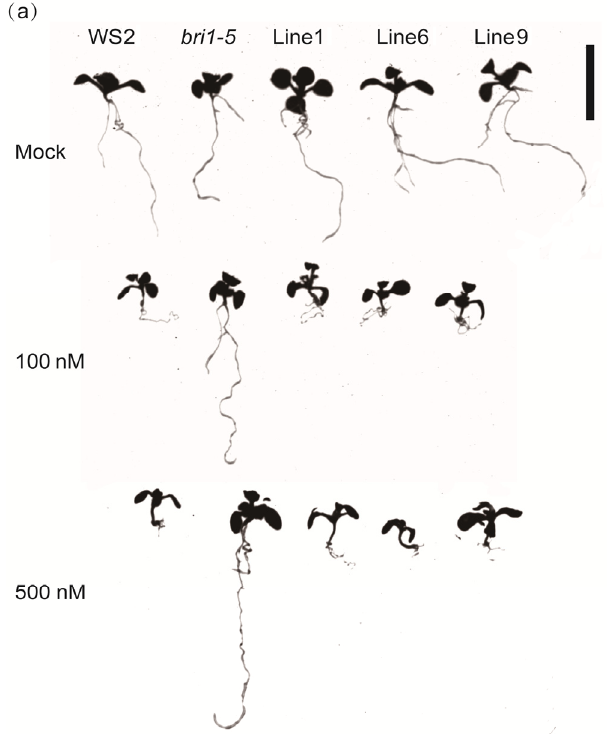
wide-type, bri1-5 mutant and transgenic lines. ( a ) Phenotypes of the wide-type (WS2), bri1-5 mutant and three transgenic lines (Line 1, 6 and 9) were grown in half-strength MS medium supplemented with 1% sucrose (Mock), 100 and 500 nM 2,4-epibrassinolide (24-epiBL) for 10 days. The images were scanned by an Epson perfection V700 photo scanner (Epson, Nagano, Japan) and WinRHIZO Pro v.2009c software (Regent Instruments, Montreal, QC, Canada). Bar = 10 mm; and ( b ) Measurements of the total root length of the seedlings shown in ( a ). The data represents the mean ± SD of three independent experiments. The asterisks indicate significant differences compared to the bri1-5 mutant ( ** , p < 0.01 by the t